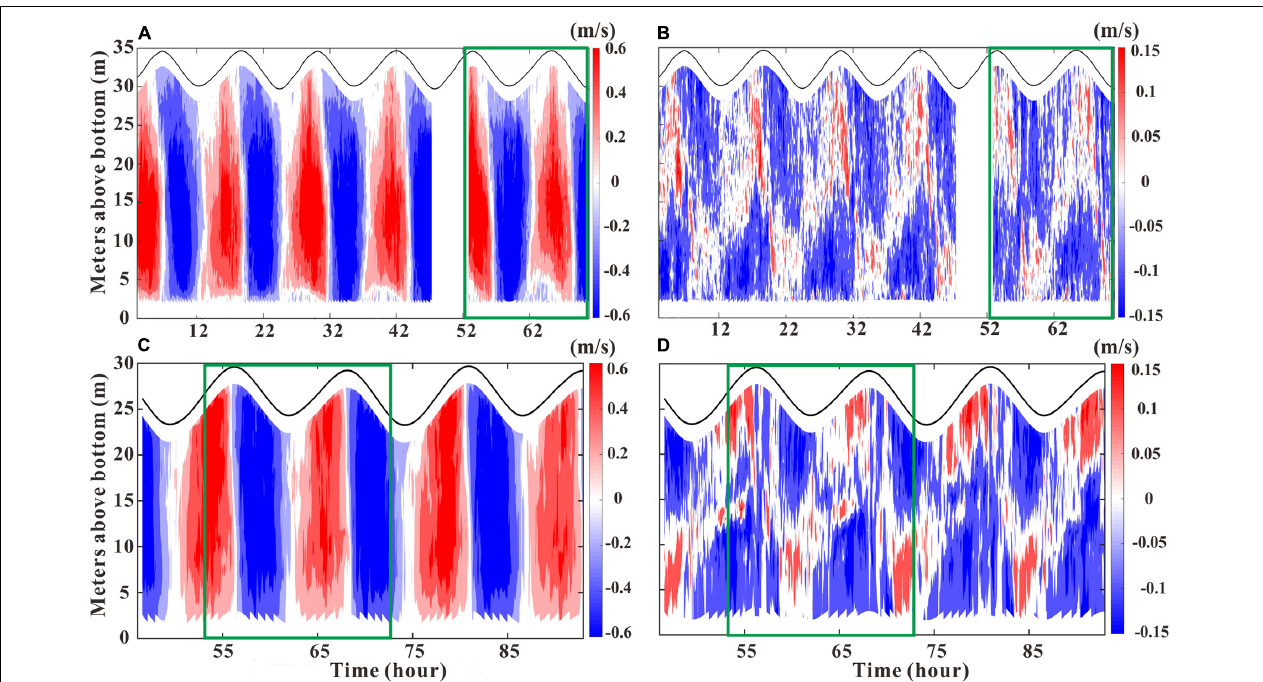
FIGURE 5 | Current velocity profile of u and v at GJ-01 (A,B) and GJ-02 (C,D) . The green boxes indicate the current data measured synchronously at the two stations. The current profile of GJ-01 was measured by the downward-looking ADCP 600 kHz on the surface, and the current profile of GJ-02 was measured by the upward-looking ADCP 300 kHz on the